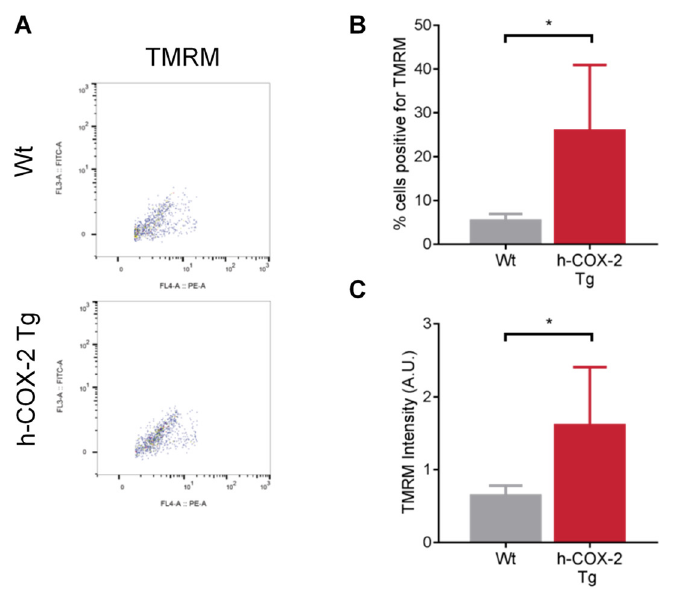
Figure 3. Assessment of mitochondrial membrane potential ( ∆Ψ m) status in liver homogenates from Wt and h-COX-2 Tg mice after I/R surgery. ( A ) Representative flow cytometry images of TMRM-labelled cells. Quantification of the percentage of TMRM-positive cells ( B ) and TMRM intensity ( C ). Bars are means ± SD of five to eight independent measures. Statistical test: Student’s t -test. * p < 0.05.